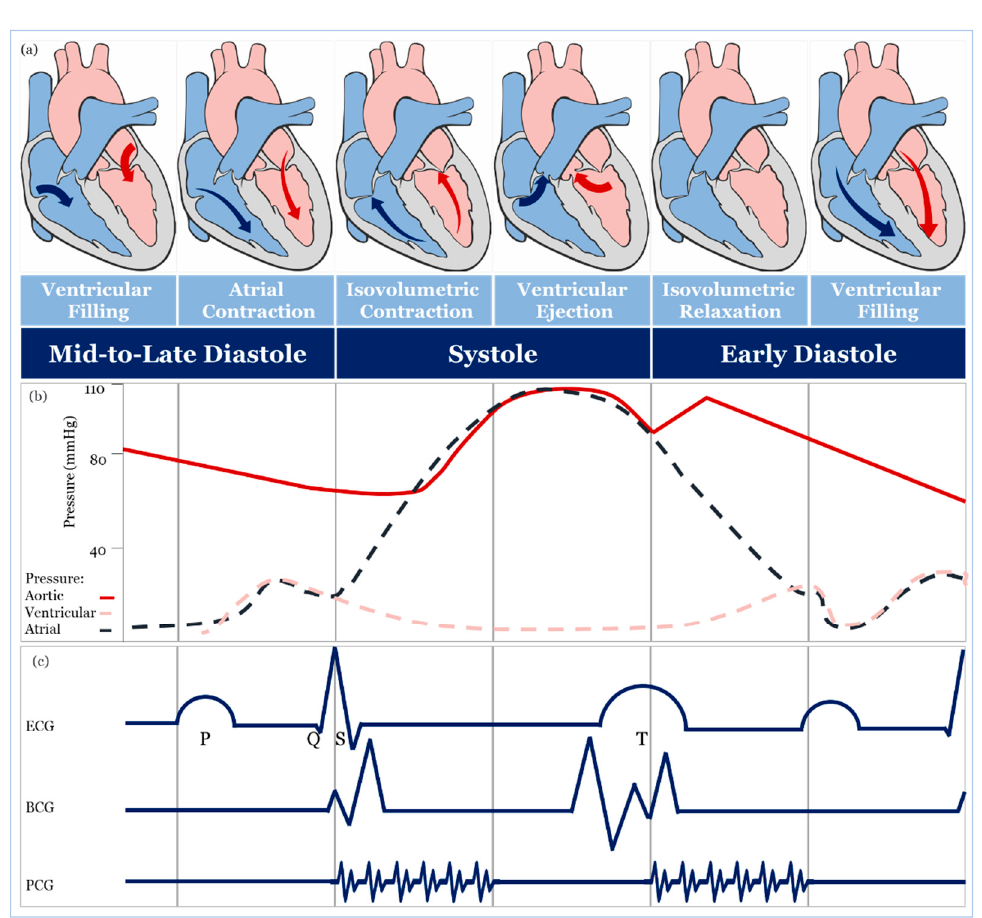
Figure 2. Schematic diagrams: ( a ) cardiac cycle, ( b ) arterial blood pressure versus ventricular and atrial blood pressure values, ( c ) morphological shapes of different signals associated with blood pressure.